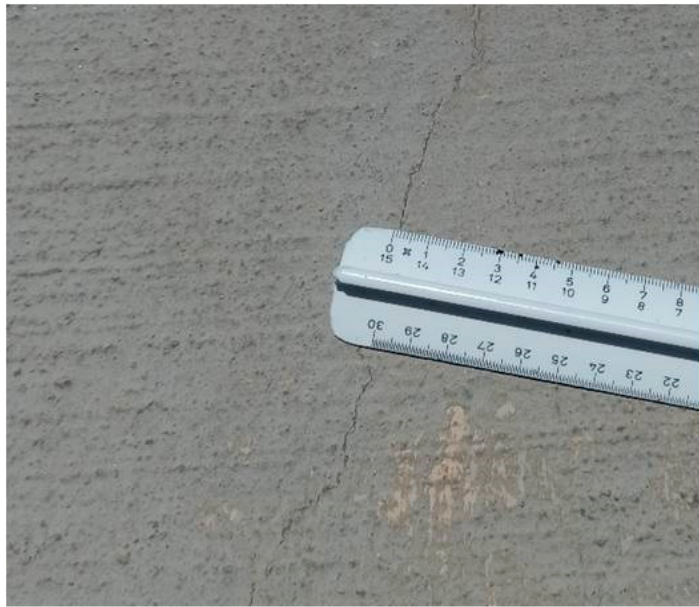
Figure 5. Cross-section of the pavement under investigation.